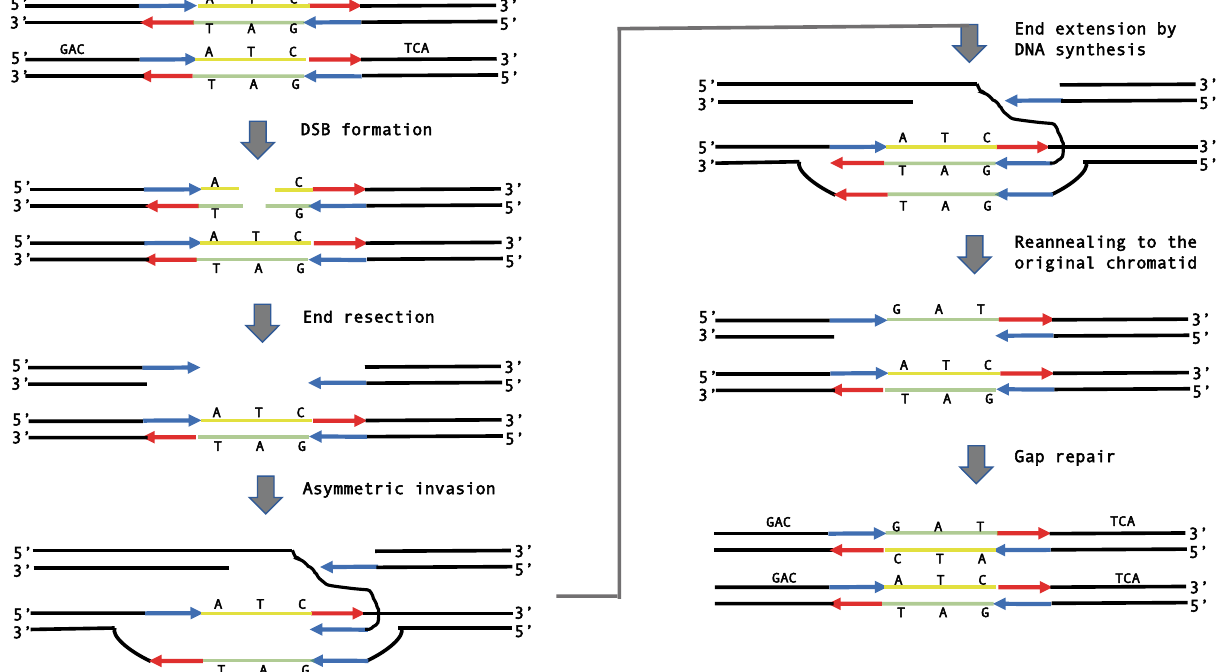
Figure 5. Microhomology-mediated BIR model for the microinversion formation. Complementary strands of a DNA segment to undergo inversion are shown as yellow and green lines. Complementary strands of flanking inverted repeats are shown as red and blue arrows; the tips of these arrows designate 3 ′ ends of inverted repeats. See text for